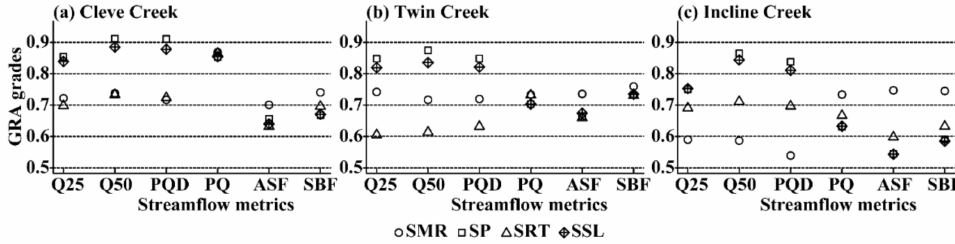
Figure 4. GRA grades between snow metrics (SMR, SP, SRT, and SSL) and flow metrics (Q25, Q50, PQD, PQ, ASF, and SBF).